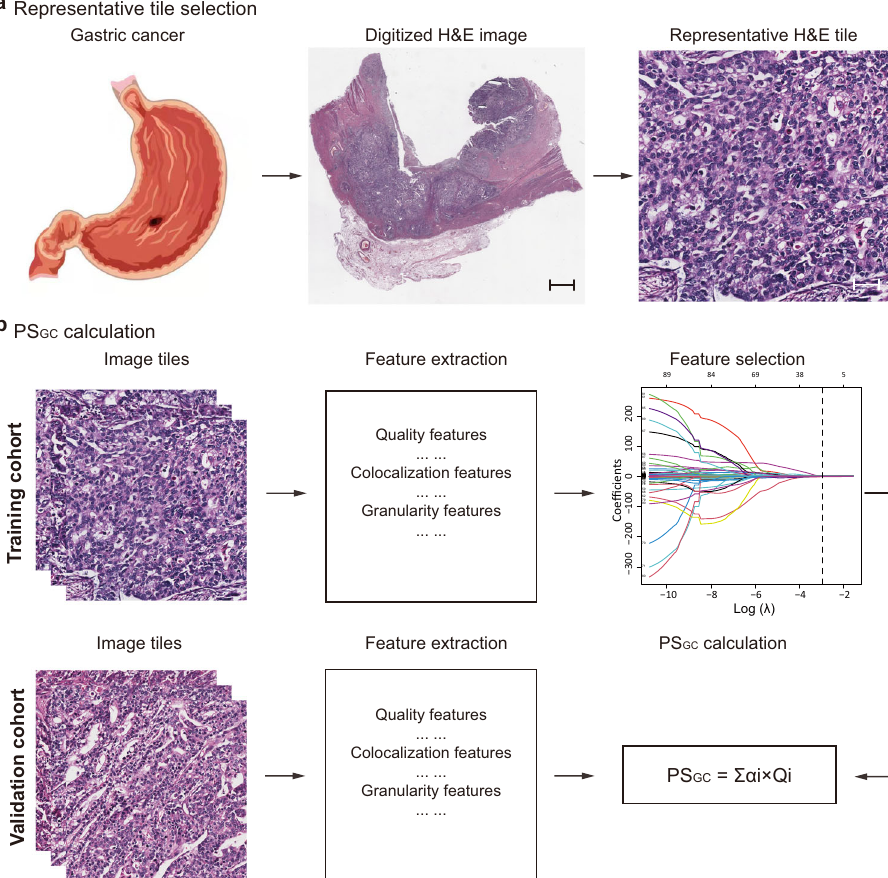
Fig. 1 | Schematic illustration of PS GC construction. a Selection of a representa- tive H&E tile. The H&E-stainedimages of all included 480 patients are used, and 10 regions of interest with a fi eld of view of 1000×1000 pixels per image containing thegreatestnumberoftumourcellsarerandomlyselectedforanalysis.Onepixelis equal to 0.504 μ m. Scale bars: 1500 and 50 μ m, respectively. b Framework for constructing the PS GC . The pathomicsfeatures are extracted from the H&E-stained